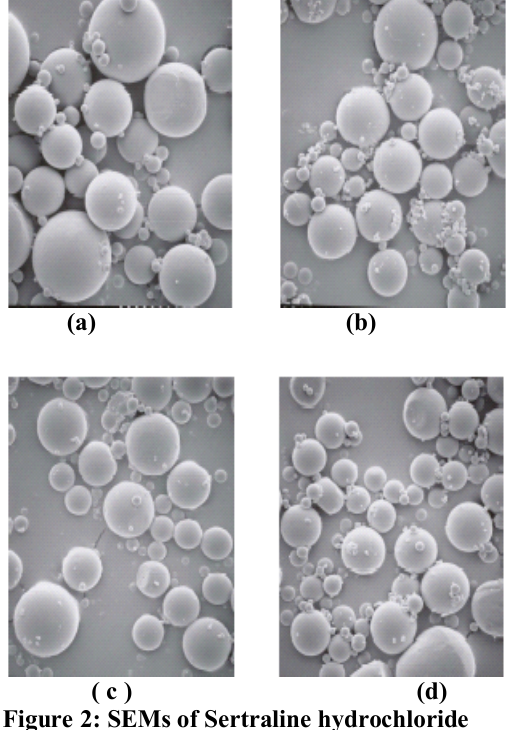
Figure 2: SEMs of Sertraline hydrochloride loaded